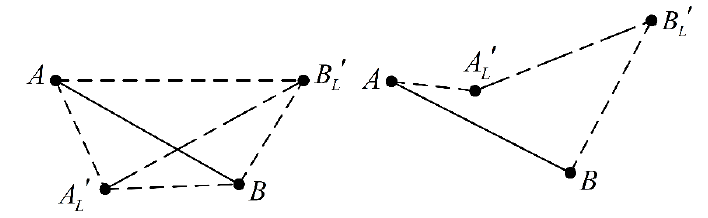
Figure 7. Virtual-support quadrilateral.